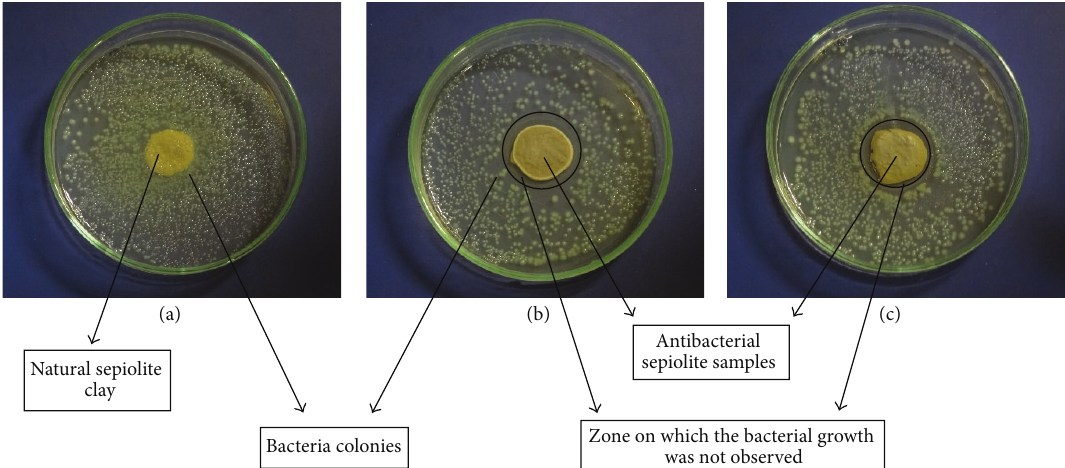
Figure 3: Antibacterial (modified halo) test results of the (a) neat, (b) physically treated, and (c) chemically treated sepiolite.